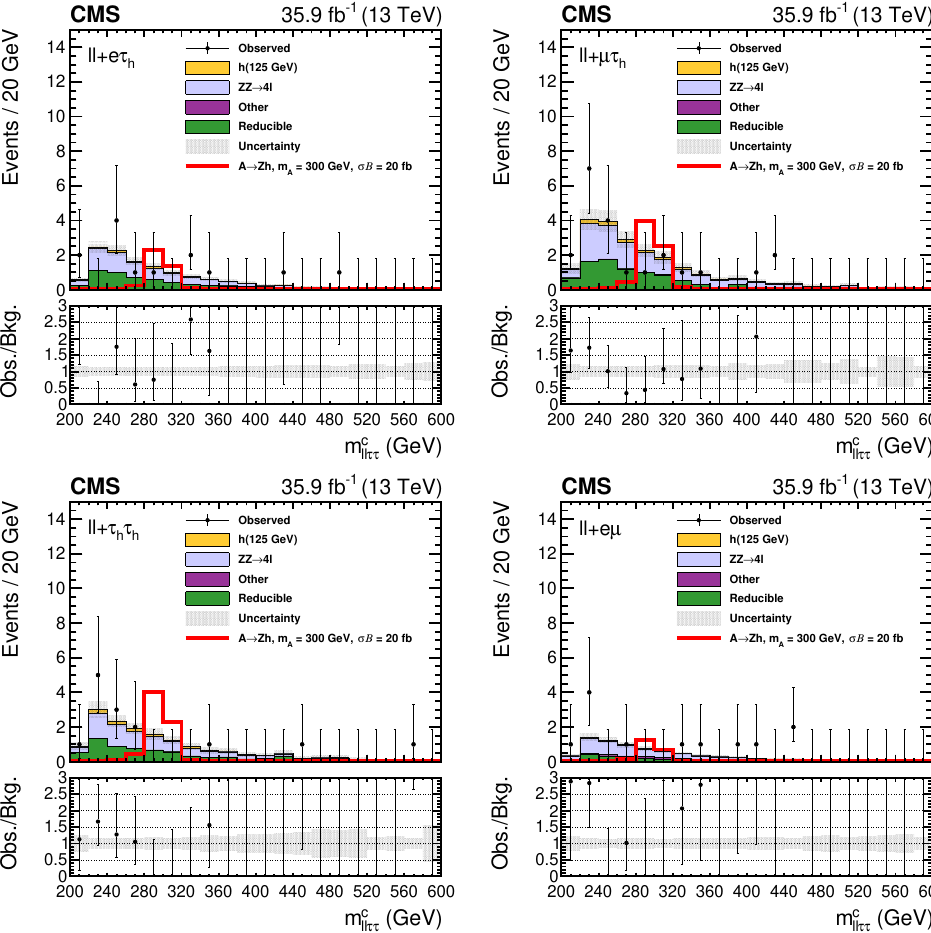
Figure 3 . The reconstructed mass m c distributions and uncertainties after a background-only ‘‘ tt (cid:12)t for the ‘‘ +e t (upper left), ‘‘ + mt (upper right), ‘‘ + t (lower left), and ‘‘ +e m (lower right) h h h t h channels. In all cases the two decay channels of the Z boson are included as separate distributions in the simultaneous (cid:12)t; combining them together is for visualization purposes only. The uncertainties include both statistical and systematic components. The expected contribution from the A ! Zh signal process is shown for a pseudoscalar Higgs boson with m = 300 GeV with the product of the A cross section and branching fraction of 20 fb and is for illustration